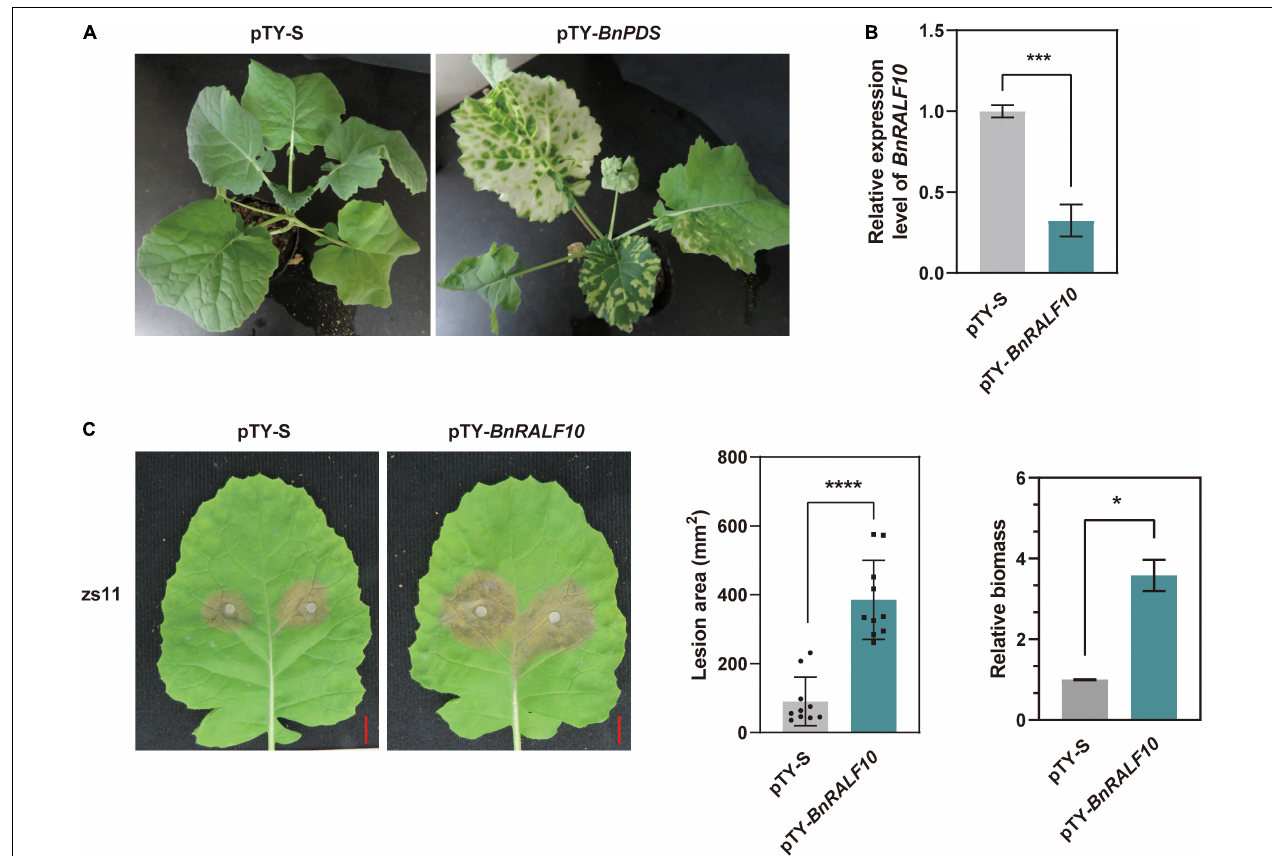
FIGURE 4 | Silencing of BnRALF10 reduced resistance to S. sclerotiorum in oilseed rape. (A) Photobleaching phenotype of BnPDS silencing in oilseed rape employing pTY-based VIGS. Empty vector pTY-S was used as a control. (B) Efficient silencing of BnRALF10 in leaves as manifested by the dramatically reduced level of BnRALF10 transcript, which was detected by qRT-PCR analysis using B. napus actin ( BnActin7 ) as reference gene. (C) Representative disease symptoms (left), lesion areas (middle) and fungal biomass (right) of BnRALF10 -silenced leaves at 24 h post inoculation with S. sclerotiorum . Scale bar: 1 cm. Data are statistically analyzed by Student’s t -test ( n = 10) and shown as the mean ± SE. The asterisks indicate significant differences (* P ≤ 0.05, *** P ≤ 0.001, **** P ≤